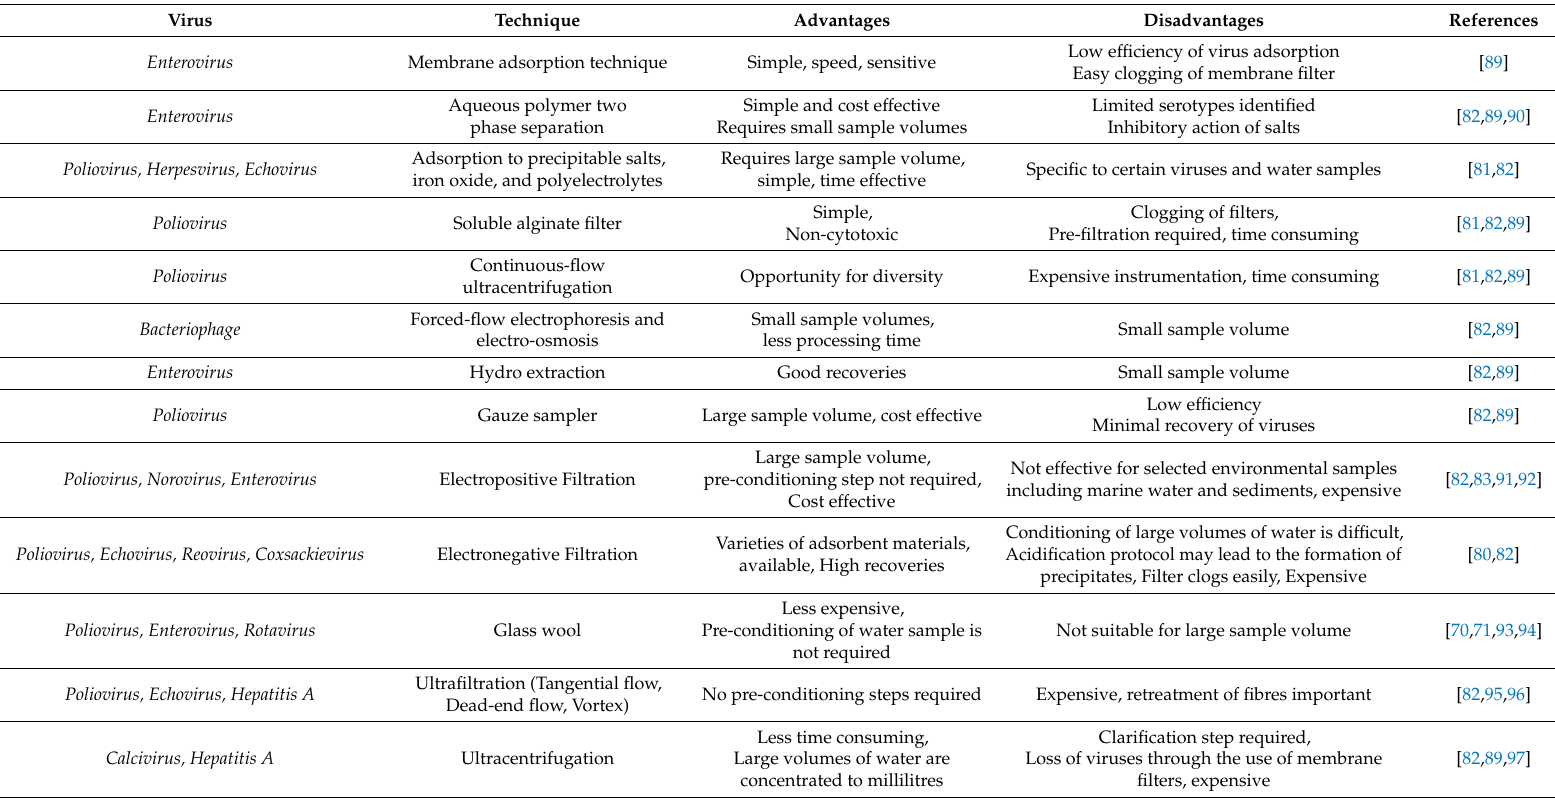
Table 2. Different concentration techniques used for the concentration, recovery and isolation of viruses in environmental